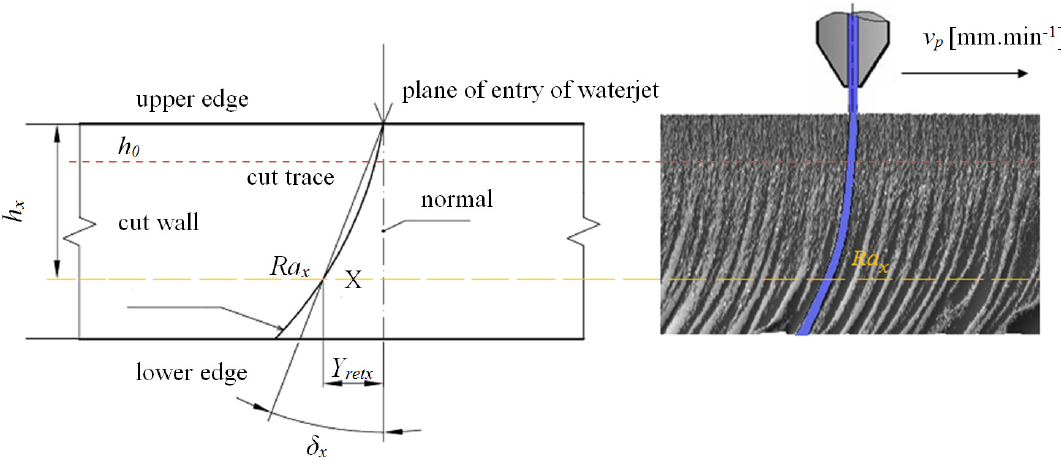
Figure 3. Geometrical parameters of the edge of cut in the case of abrasive waterjet cutting and method of determining parameters Ra x , Y retx , δ x , h x at point X in cut trace.